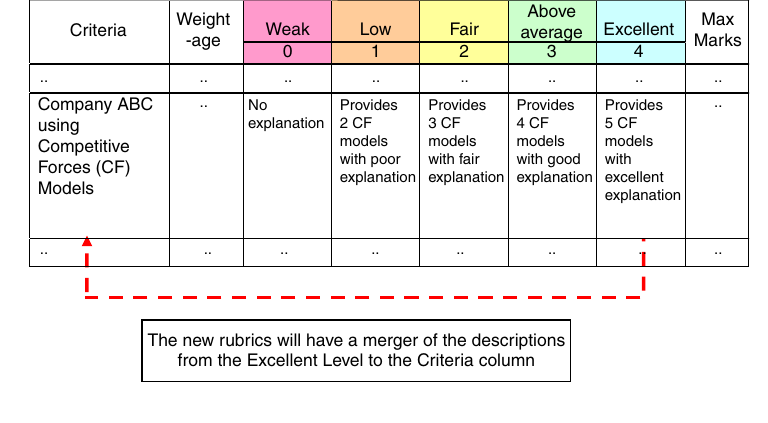
Figure 6. Merger of descriptions from excellent level column to criteria column